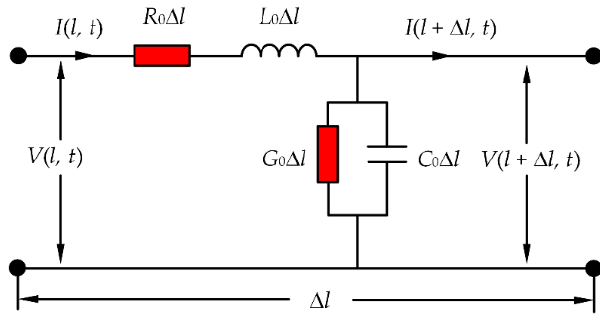
Figure 1. ∆ l -length transmission line.